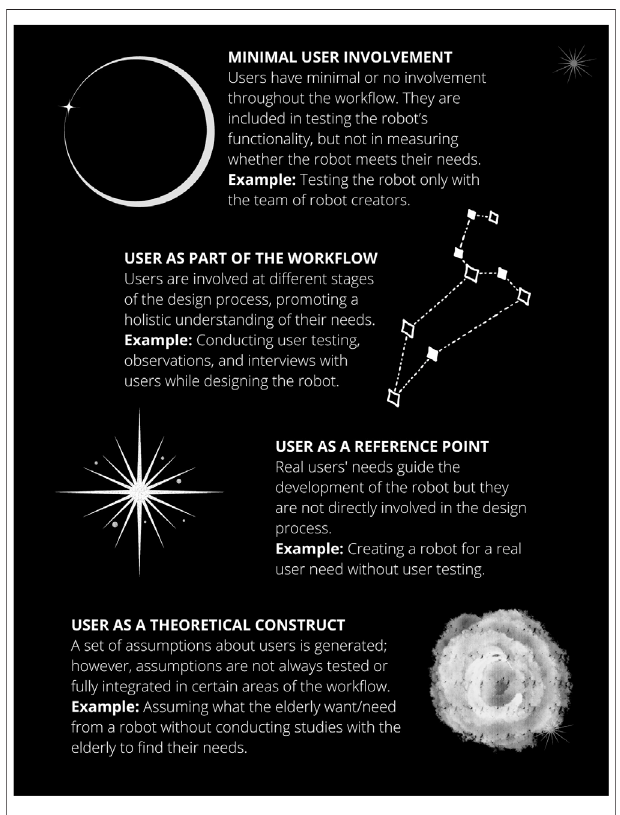
FIGURE 3 | Different degrees of user or customer involvement in the development of a social